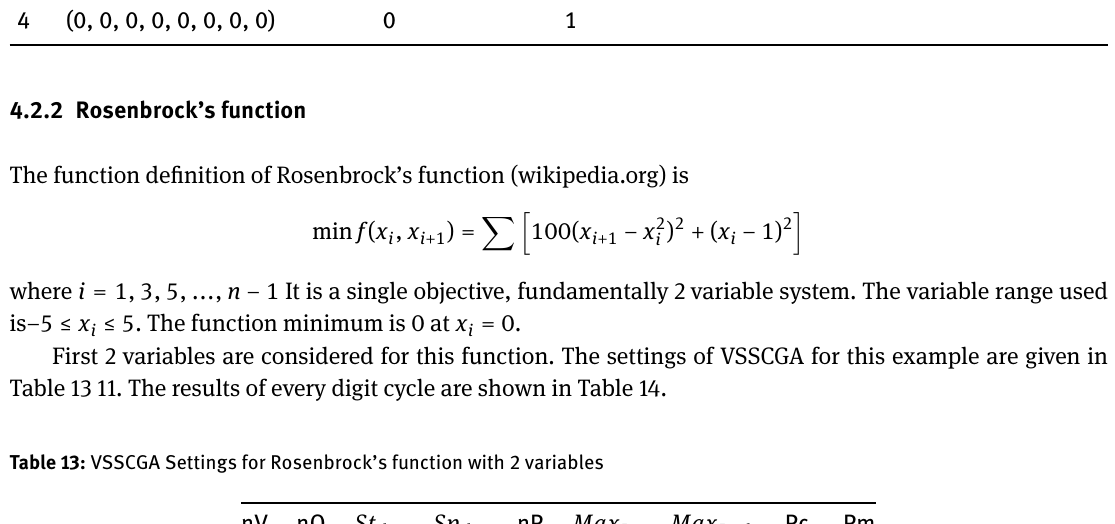
solution obtained